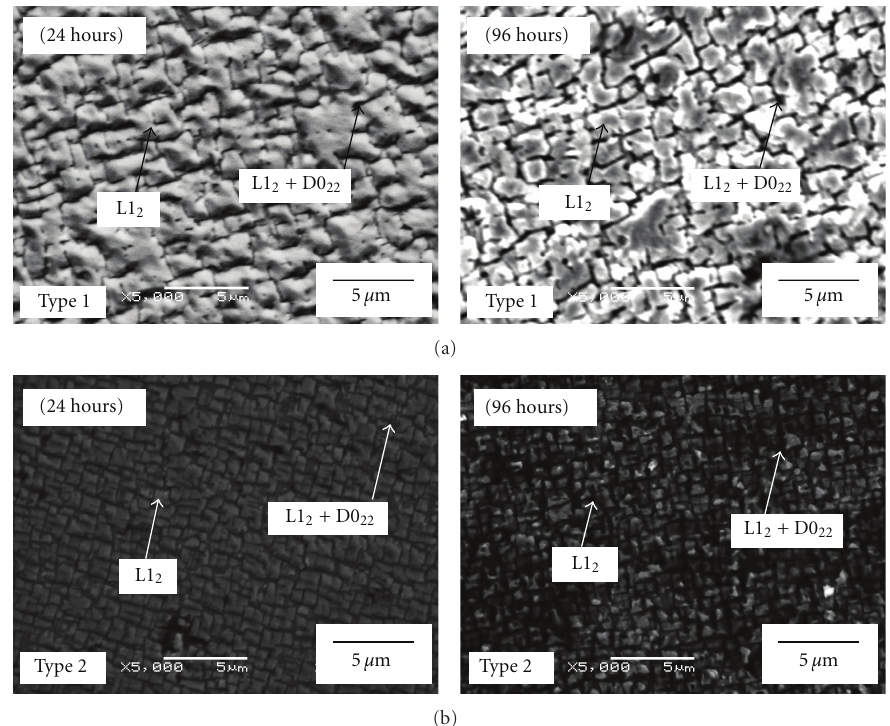
Figure 5: SEM microstructures of Ni 3 Al/Ni 3 V two-phase intermetallic compounds: (a) type 1 and (b) type 2 after the immersion times of 24 hours and 96 hours in 0.5 kmol/m 3 HCl solution at 303 K.